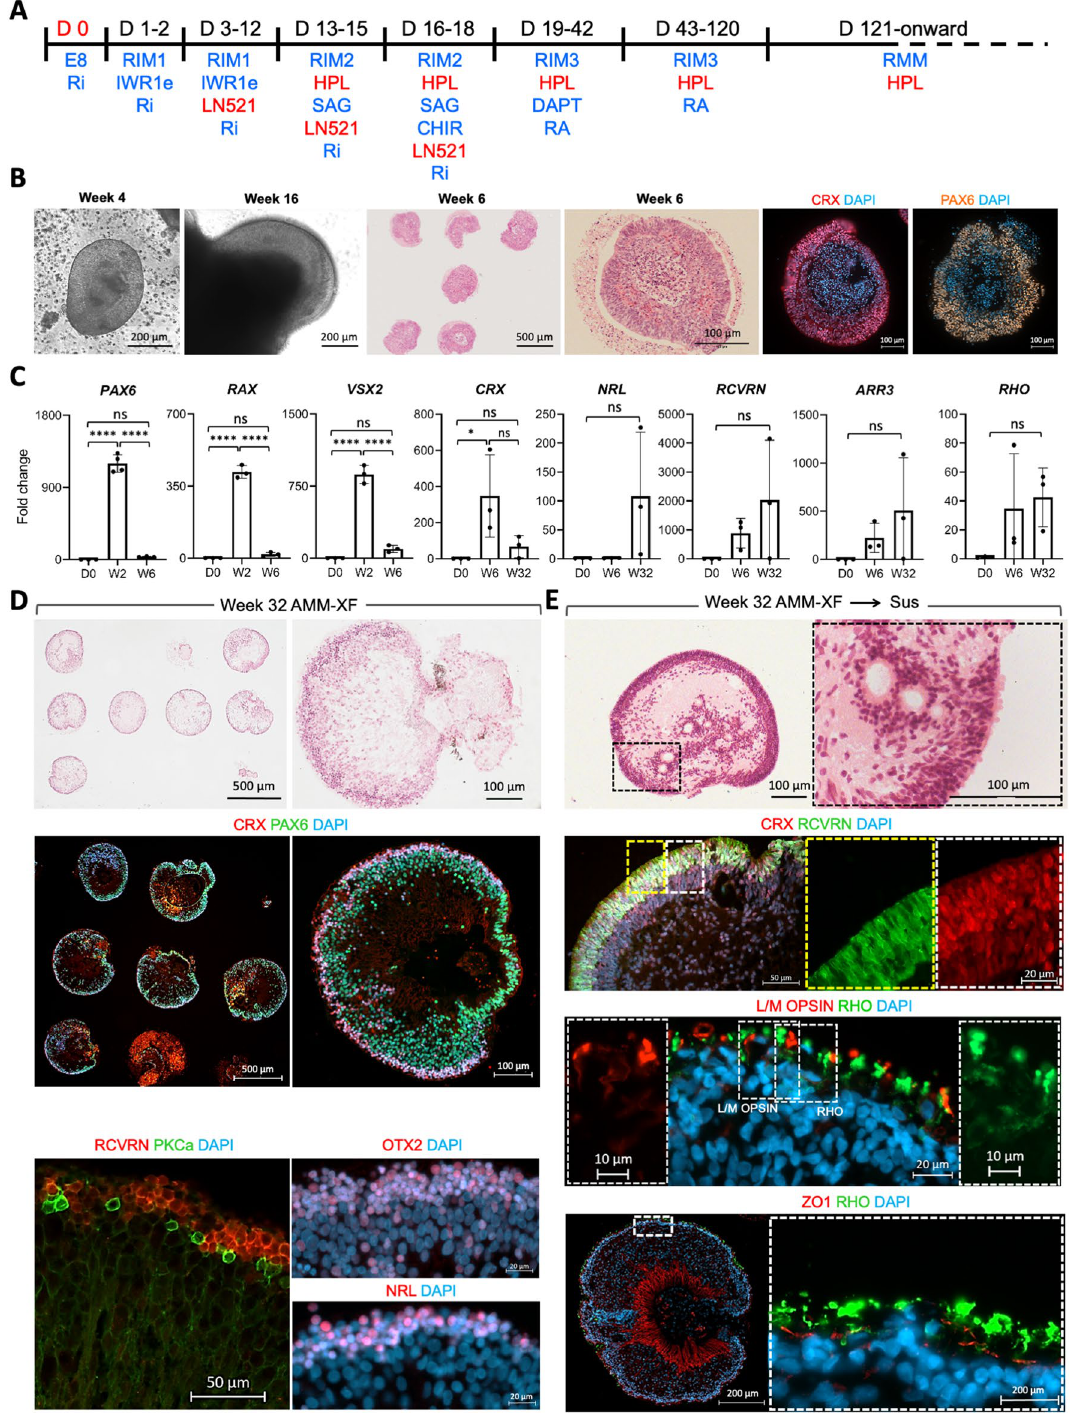
Figure 4. Retinal differentiation in 3D AMM without animal-derived supplements (xeno-free). ( A ) Schematic of the 3D AMM xeno-free small molecule protocol ( B ) Bright field images and immunohistological analysis of retinal organoids at wk 4, 6, and 16 of differentiation ( C ) RT PCR analysis of relative expression of retinal marker genes (mean ± SD; n = 3 independently cultured AMMs, each containing over 50 OVs from MShef10 ESC differentiation). ( D , E ) Immunohistological analysis of retinal organoids at week 32 of differentiation, maintained in AMMs ( D ) or transferred from AMM into suspension culture from week 6 of differentiation ( E ; Sus). Data shown from differentiations of MShef10 ESC